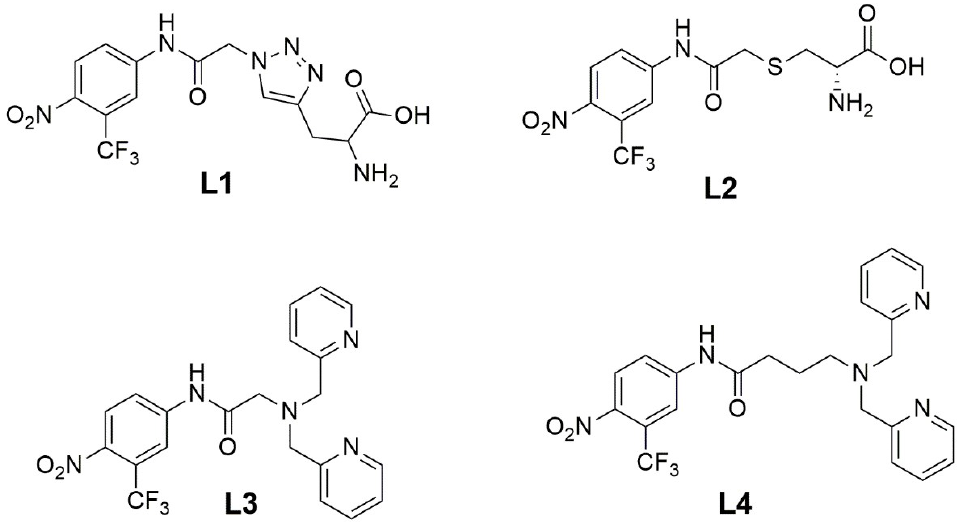
Figure 1. Structures of flutamide derivatives used as ligands for the preparation of 99m Tc complexes.